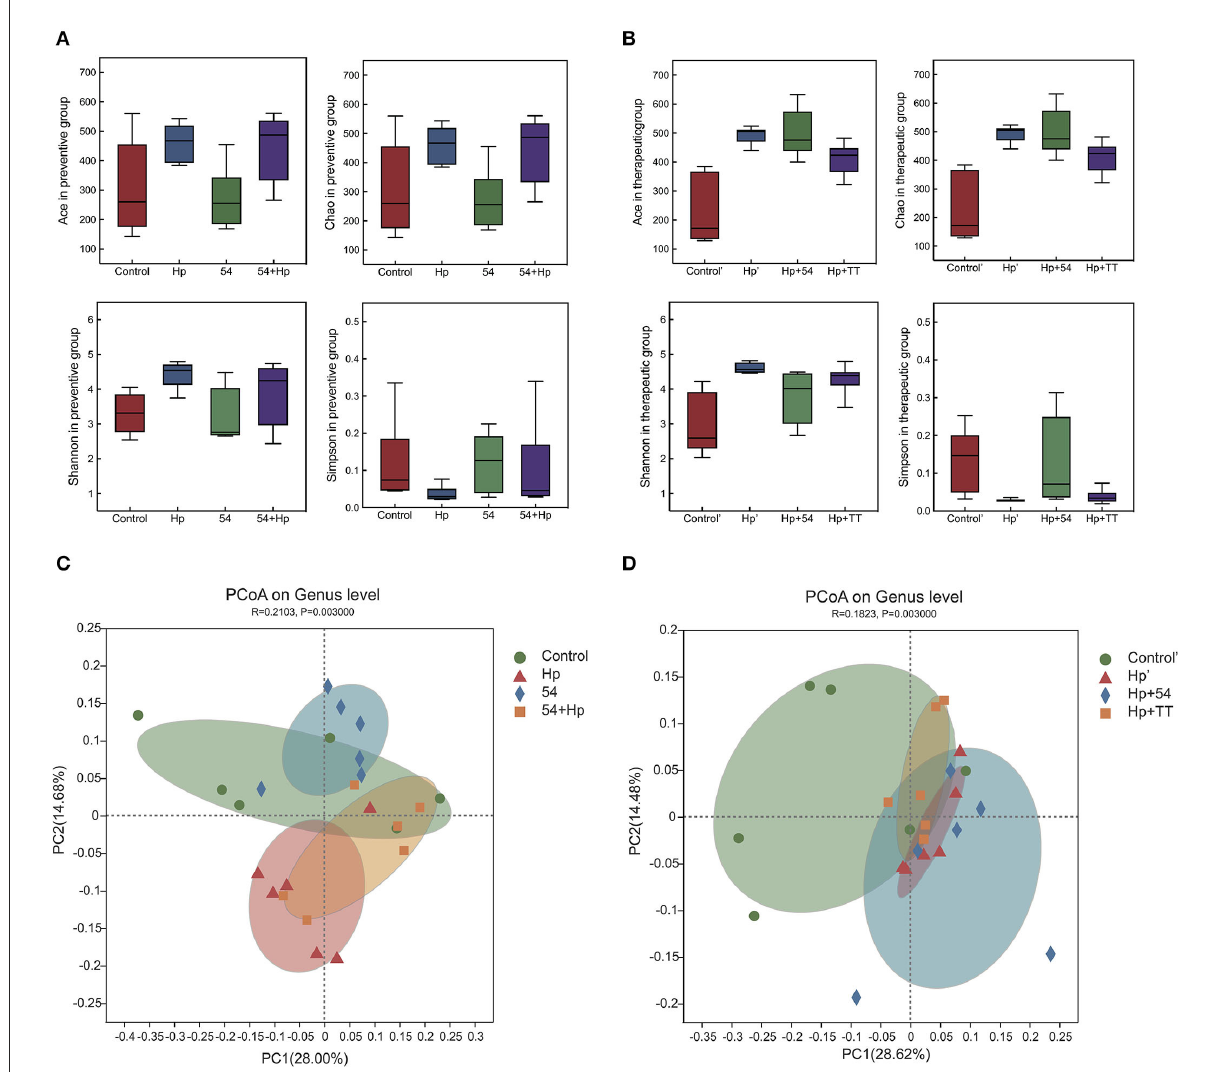
FIGURE7 Bacterial alpha and beta diversity in the preventive and therapeutic groups. (A) Alpha diversity (Ace, Chao, Shannon, and Simpson) in the preventive group. (B) alpha diversity (Ace, Chao, Shannon, and Simpson) in the therapeutic group. (C) PCoA on genus level in the preventive group. (D) PCoA on the genus level in the therapeutic